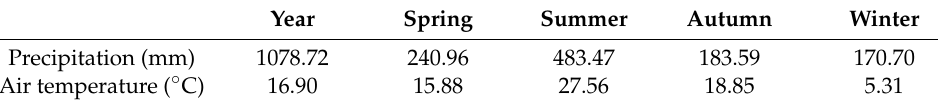
Figure 1. Study area. Table 1. Precipitation and air temperature from 2002 to 2014. Table 1. Precipitation and air temperature from 2002 to